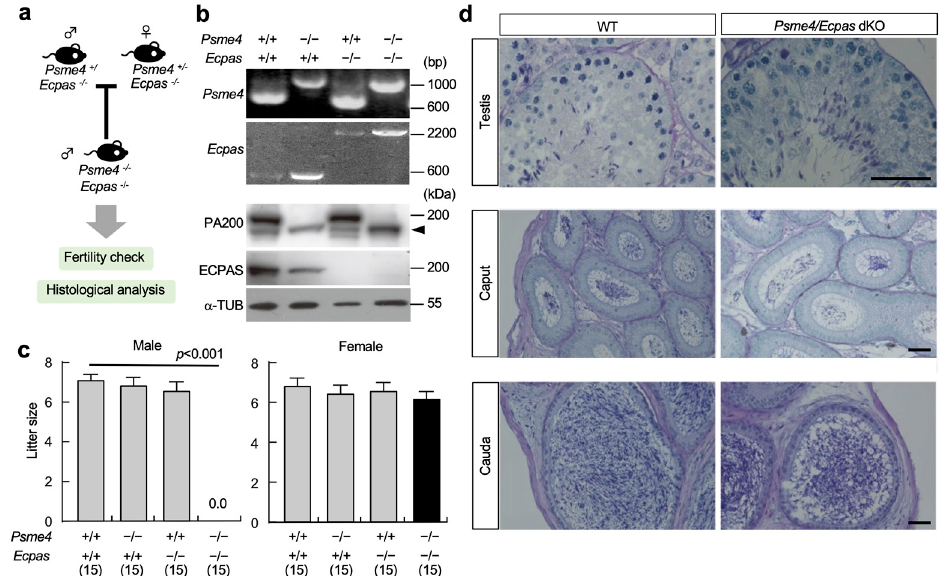
Figure 2. Generation of Psme4/Ecpas double knockout (dKO) and male infertility: ( a ) Experimental flow of generation and analysis of dKO mouse; ( b ) Genotyping and immunoblotting of Psme4 (PA200) and Ecpas (ECPAS) in dKO mice. Arrowhead: non-specific band of PA200; ( c ) Fecundity of male and female dKO mice ( n = 15). Data are expressed as the mean ± standard error; ( d ) PAS staining images of testes and epididymides in wild-type (WT) and dKO mice. Scale: 40 µm.